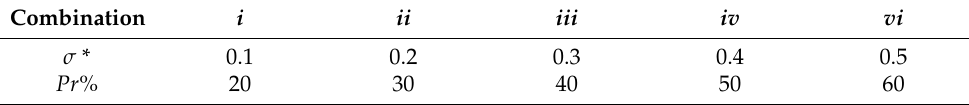
Table 2. Values of the five different conditions ( σ and Pr %) applied to each original signal. Combination